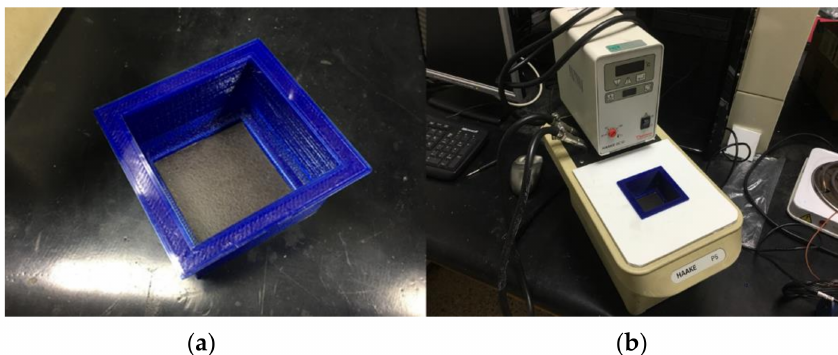
Figure 1. Temperature calibration material. ( a ) Blackbody placed inside a sealed container to isolate the upper surface from the water. ( b ) Thermally controlled water bath with the blackbody placed inside the closed bath container.